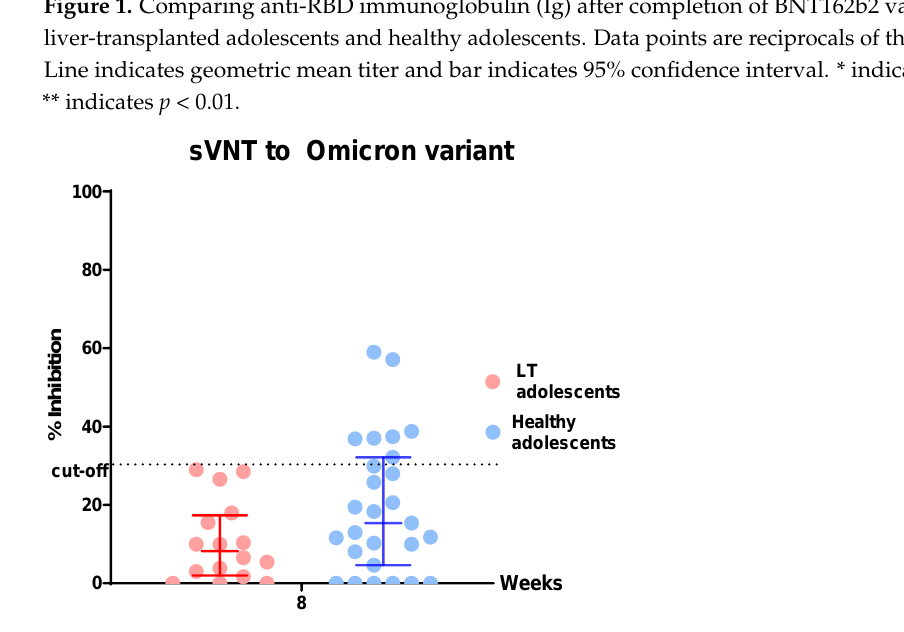
Figure 2. Comparison of % sVNT inhibition to the Omicron variant after completion of BNT162b2 vaccination in liver-transplanted adolescents and healthy adolescents. Data points are reciprocals of the individual. Line indicates geometric mean titer and bar indicates 95% confidence